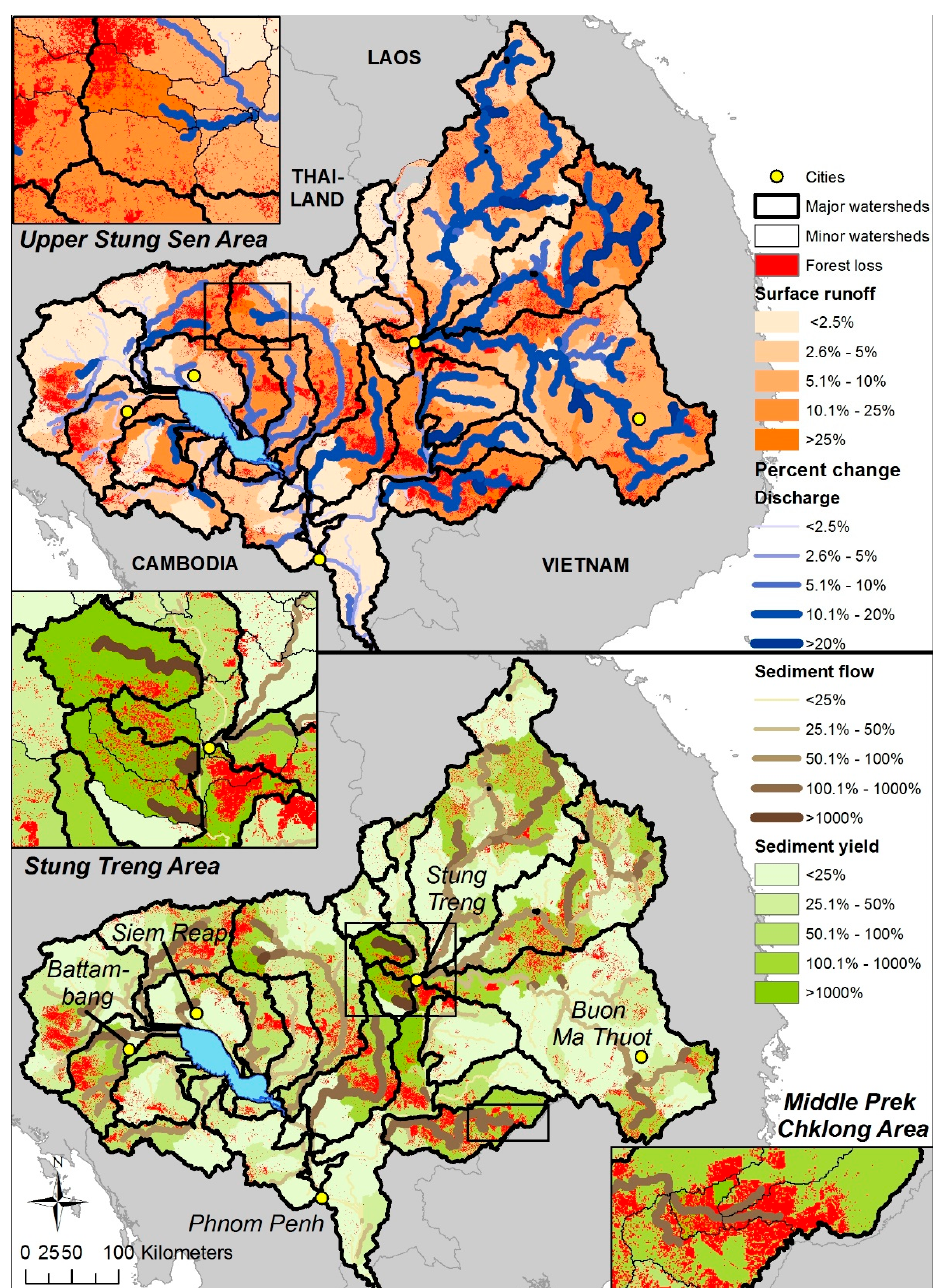
Figure 7. Percent change in several hydrological indicators due to forest loss in the lower Mekong watershed from 2001–2013. The upper figure shows change in surface runoff and stream discharge, while the lower figure shows sediment yield and flow.